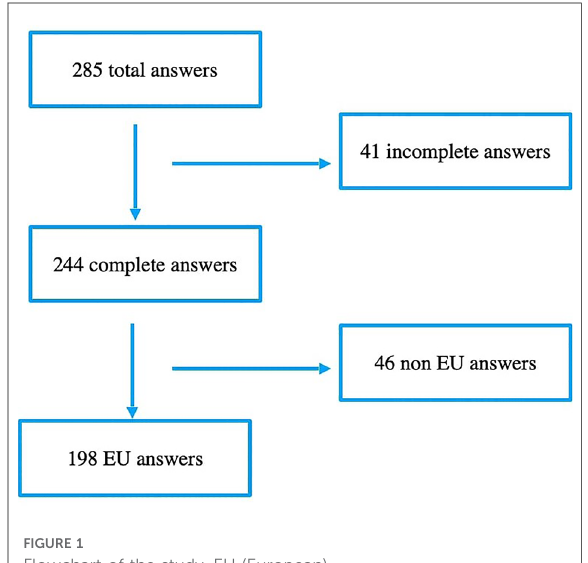
FIGURE 1 Flowchart of the study. EU (European).